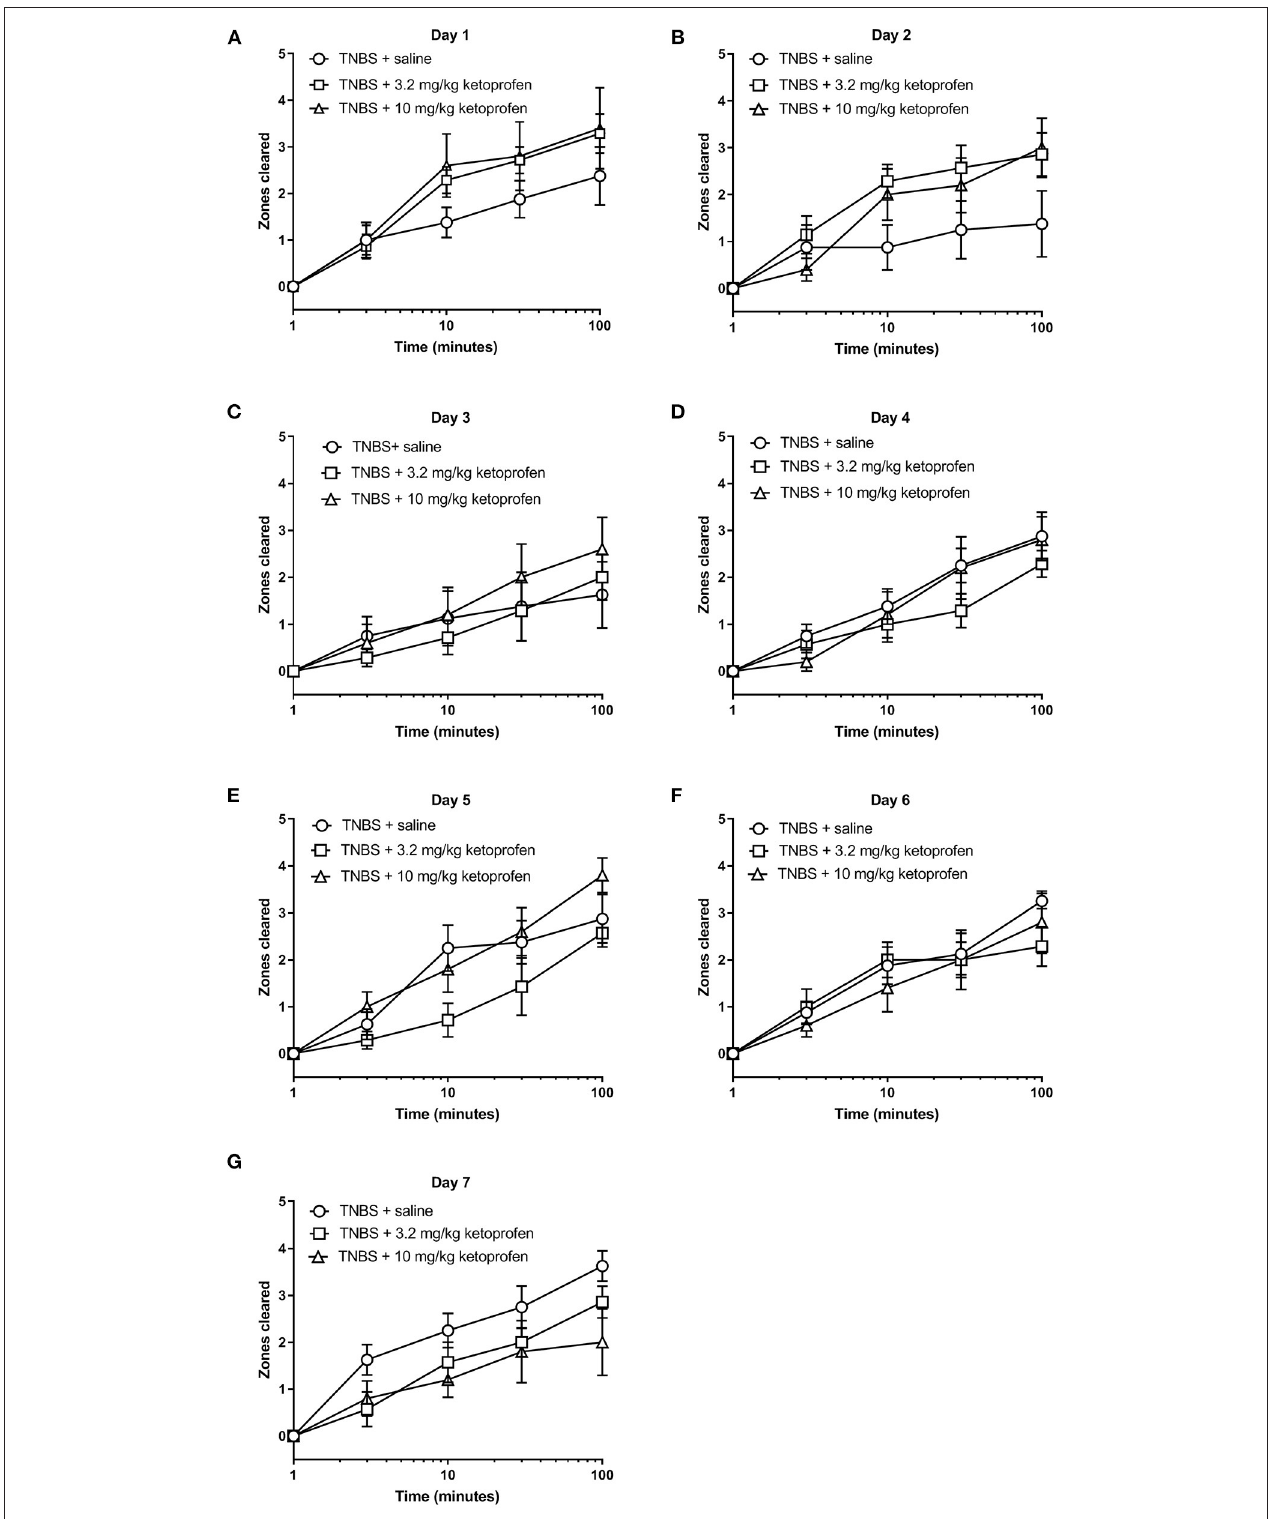
FIGURE 13 | Effect of Ketoprofen on TNBS-induced nesting. (A–G) show zones cleared at 3, 10, 30, and 100min in mice treated daily with saline or ketoprofen (3.2 or 10 mg/kg/day) on Days 1–7, respectively. Nesting scores were recorded 30min after saline or ketoprofen treatment. Compared to saline, ketoprofen did